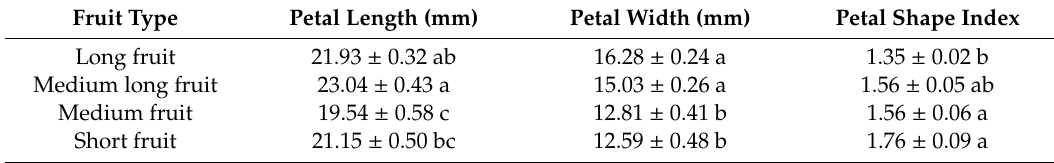
Table 5. The female flower petal shape traits of four types of cucumber fruits.